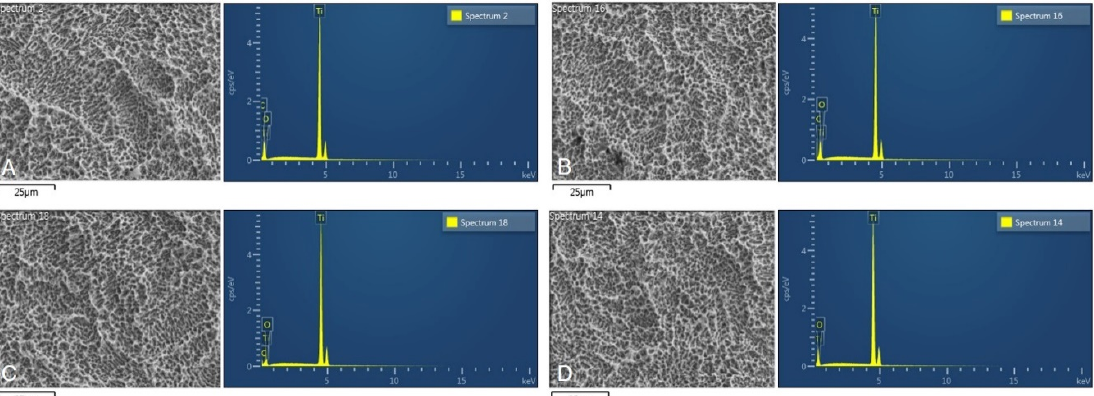
Figure 4. Scanning electron microscope (SEM) images and energy-dispersive spectrometry (EDS) analyses of SLA titanium surfaces irradiated with various types of lasers and nonirradiated specimens: ( A ) control specimen, ( B ) specimen irradiated with K2 mobile laser, ( C ) Epic 10 TM laser, and ( D ) Saeshin laser.